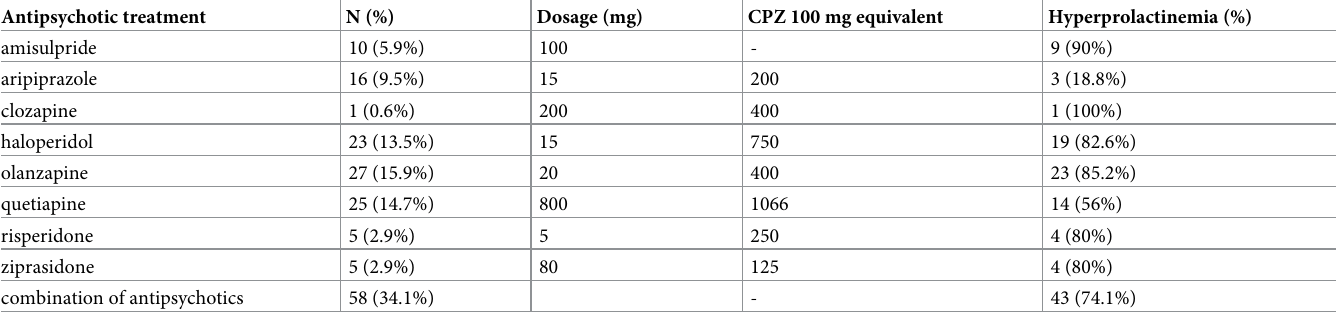
Table 3. Sample distribution according to antipsychotic medication and hyperprolactinemia.